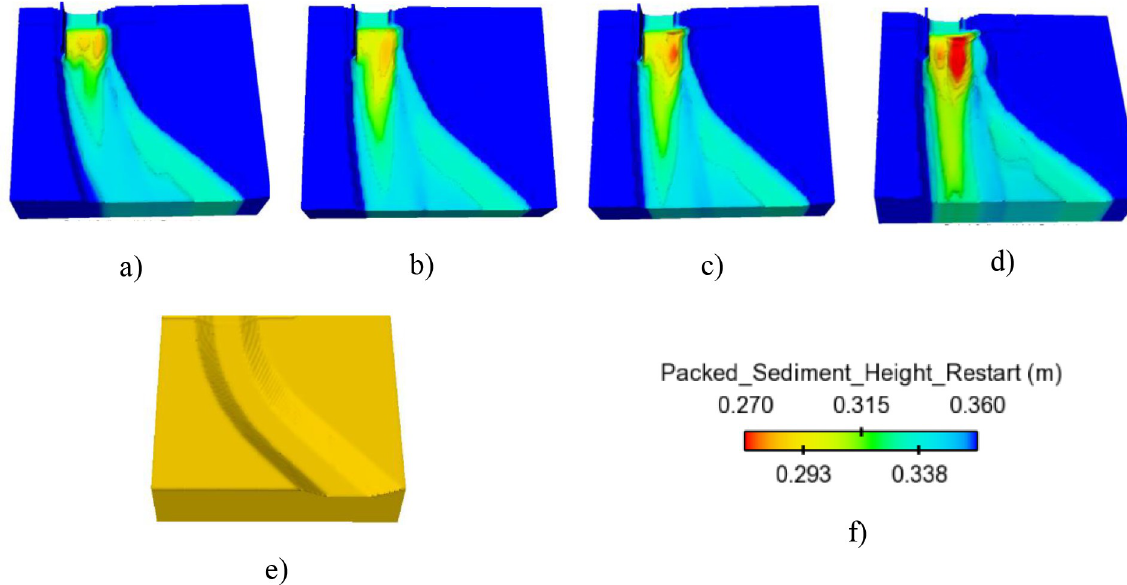
Fig 9. The effect of c bar of packed sediment height.